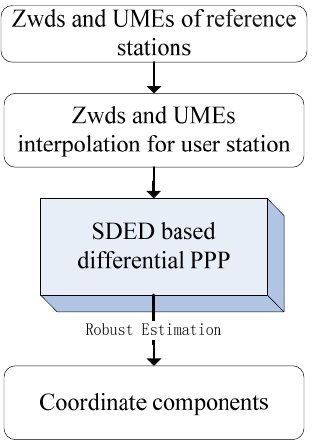
Figure 1. Flow chart of the SDED based differential PPP